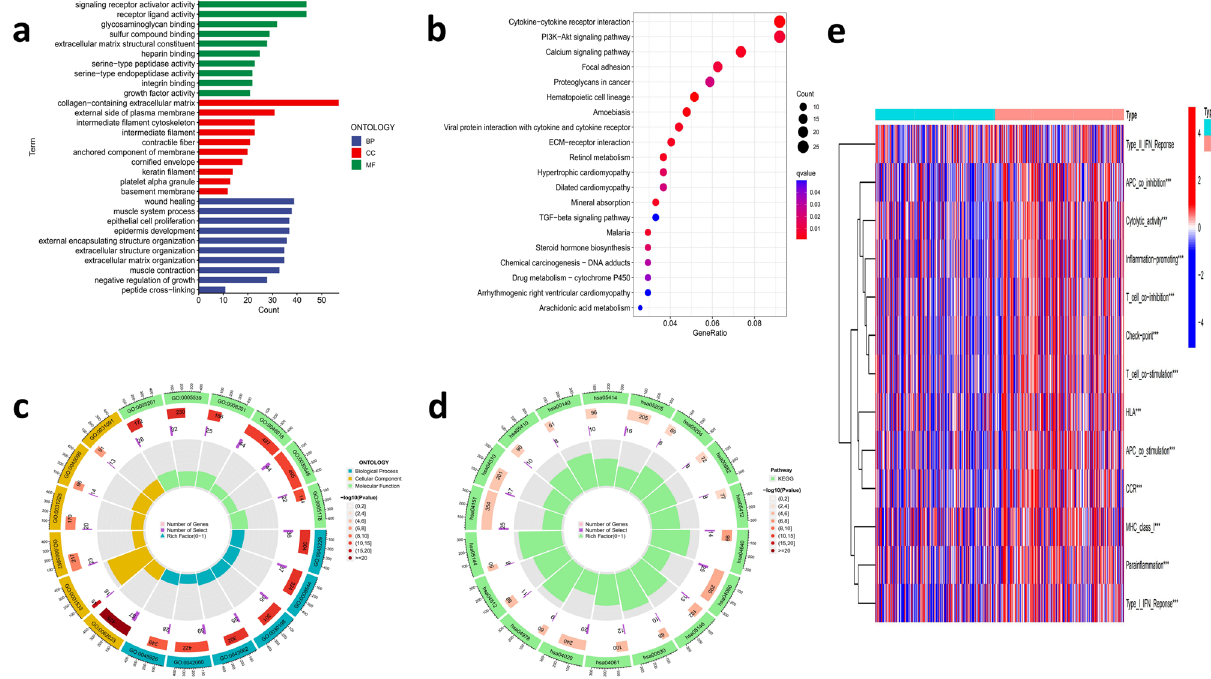
Fig. 9 Functional enrichment analysis and immune infiltration level analysis a , c GO enrich analysis and b , d KEGG enrich analysis results. e Heatmap of immune infiltration based on ssGSEA